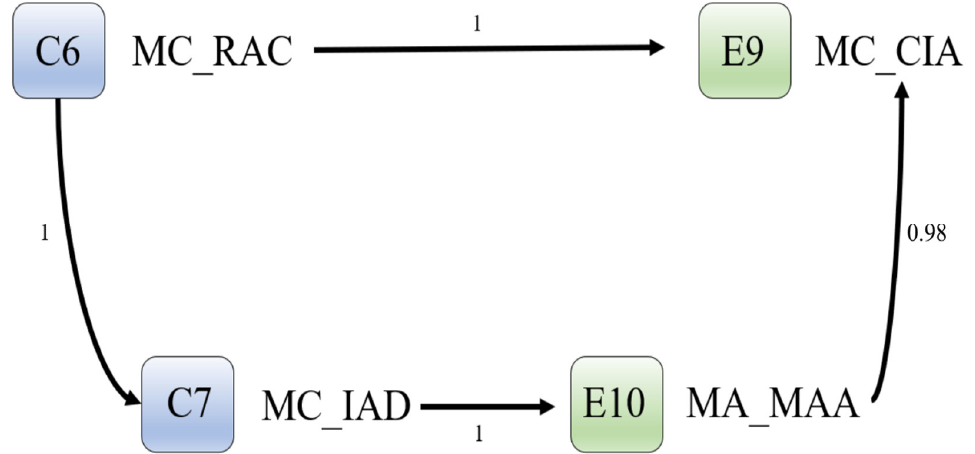
Figure 5. Incidence of knowledge mobilization C 6 → E 9 . Source: Own elaboration. C 6 MC_RAC: I am